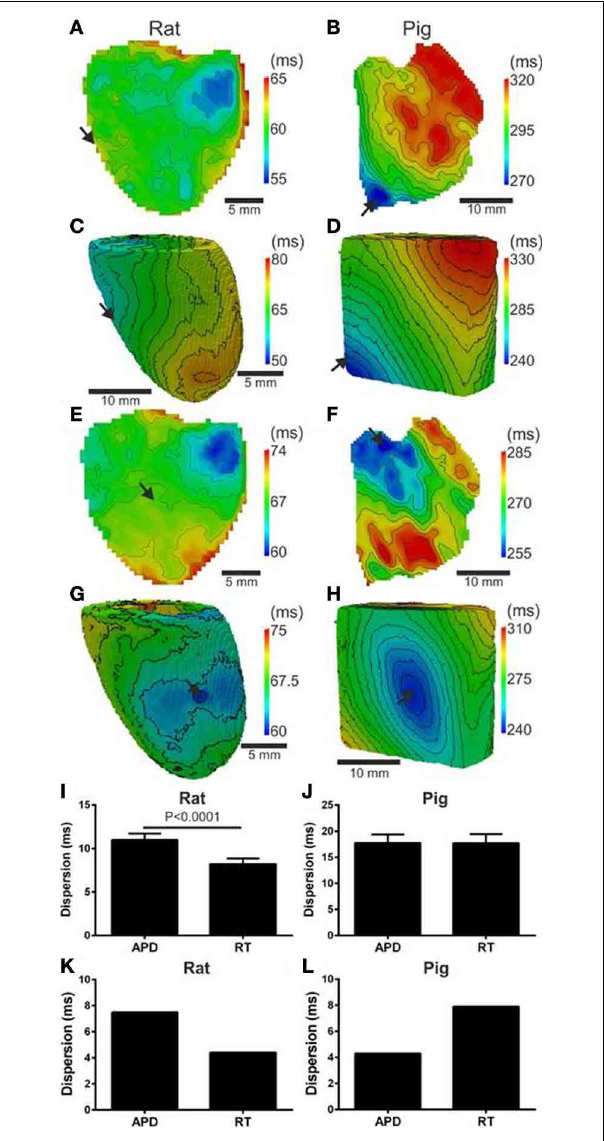
FIGURE 3 | Correlations between AT and APD in rat and pig myocardium. AT and APD plots corresponding to maps shown in Figure 1 for rat (A) and pig (B) experiments. Slopes for linear correlation analyses are indicated. AT and APD plots of corresponding simulations are shown for rat (C) and pig (D) . Similarly, AT and APD plots from an alternative pacing location, as in Figure 2 , are shown for rat (E) and pig (F) experiments and rat (G) and pig (H) simulations. Panels (A–H) are also expressed as a percentage of the maximum APD 80 . Mean ± SD APD corresponding to 4 and 10ms activation isochrones across all experiments and pooled from each pacing location in rat (I) and pig (J) . (K) Equally, slopes of linear correlations between AT and APD were quantified for all experiments and pacing locations and expressed as Mean ± SD . Similarly to experiments, early vs. late activation times were compared for rat (L) and pig (M) simulations shown in Figure 2 . (N) Slopes from linear correlations of corresponding AT and APD data are compared. All mean differences were compared using t -tests. Significant differences are indicated if P < 0 . 05.